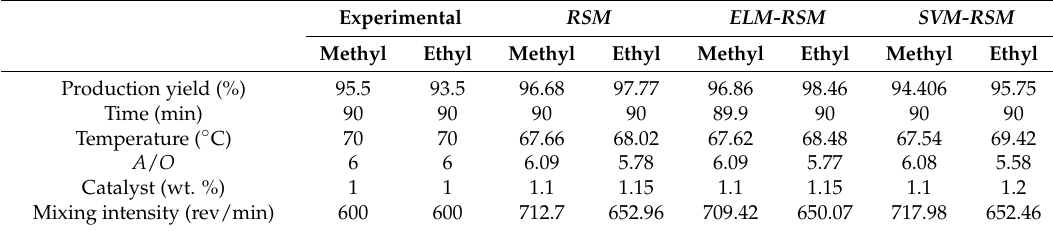
Table 8. General results of